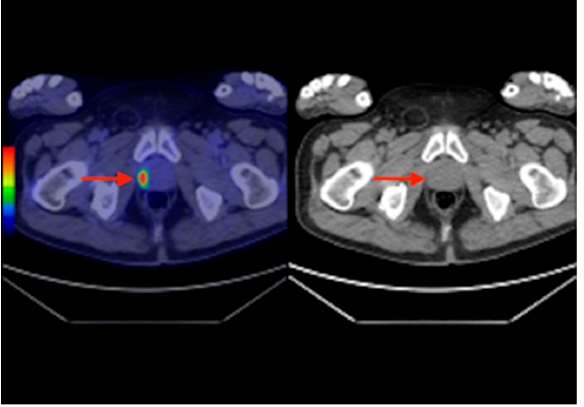
Figure 7. Axial section F18-FDG PET-CT (left) and CT (right) revealing an increased uptake in the right prostate lobe (red arrows) suggesting a primary prostate carcinoma, confirmed in histology.